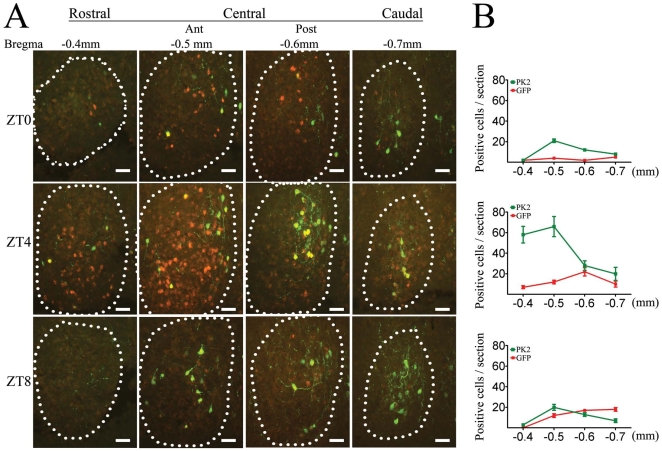
The EGFP reporter labeled a subset of PK2 mRNA-expressing neurons in the SCN.A. On consecutive coronal sections of the SCN at ZT0, ZT4 and ZT8, fluorescence in situ hybridization for PK2 mRNA (in red color) and immunofluorescence staining against EGFP protein (in green color) revealed partial overlap between the PK2 mRNA and the EGFP reporter expressions. Most of the PK2 mRNA-expressing cells in the caudal part of the SCN were successfully labeled by the EGFP reporter, but the majority of PK2 mRNA-expressing cells in the rostral part of SCN did not express EGFP reporter. Scale bar  =  50 µm. B. Quantification of PK2 mRNA-positive and EGFP protein-positive cells at different ZT time points. Error bars (SEM) were present in all data points, although some were too small to see.